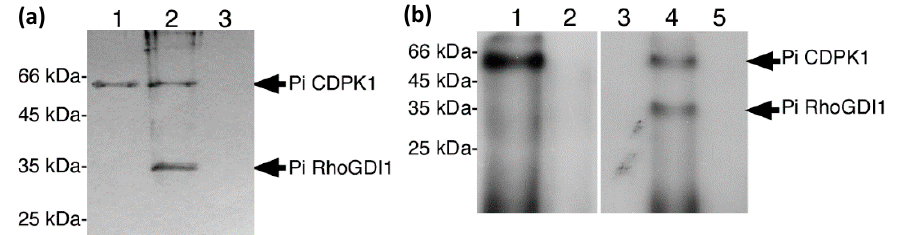
Figure 2. PiCDPK1 interacts with and phosphorylates PiRhoGDI1 in vitro. ( a ) Pull down assay. His-tagged protein samples were incubated with phenyl sepharose resin, washed, separated by SDS-PAGE, and blotted to PVDF membrane. Immuno-detection was performed with anti-His tag monoclonal antibody. Lanes represent the following samples: (1) PiCDPK1 alone, (2) PiCDPK1 and PiRhoGDI1, (3) PiRhoGDI1 alone. PiRhoGDI1 was only detected in combination with PiCDPK1, suggesting that the two proteins interact. ( b ) In vitro phosphorylation assay. Phosphorylation assays were performed in the presence of 50 µ M Ca 2+ to stimulate PiCDPK1 or 1 mM EGTA to inhibit PiCDPK1. Samples were separated by SDS-PAGE and subjected to autoradiography. Lanes: (1) PiCDPK1 + Ca 2+ , (2) PiCDPK1 + EGTA, (3) PiRhoGDI1 + Ca 2+ , (4) PiRhoGDI1 + PiCDPK1 + Ca 2+ , (5) PiRhoGDI1 + EGTA. PiRhoGDI1 was phosphorylated only in the presence of PiCDPK1 and Ca 2+ .